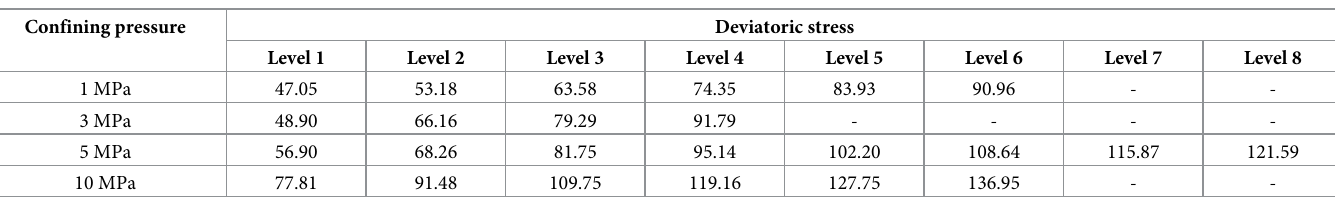
Table 2. Deviatoric stress at each level.